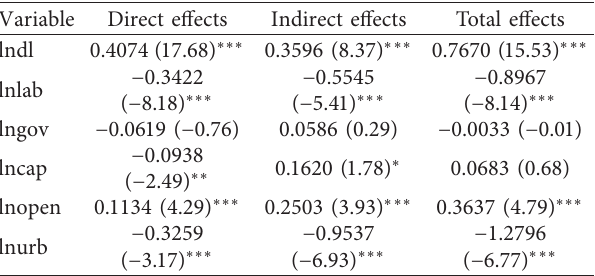
Table 7: Spatial effect decomposition in the time-fixed-effects model.